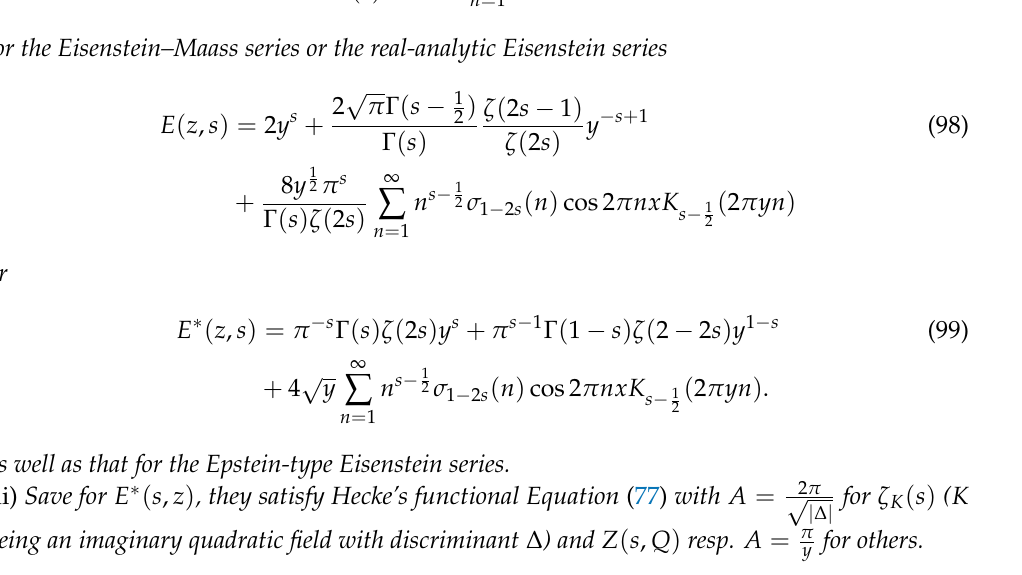
Table 3. Epstein zeta-functions and non-holomorphic Eisenstein